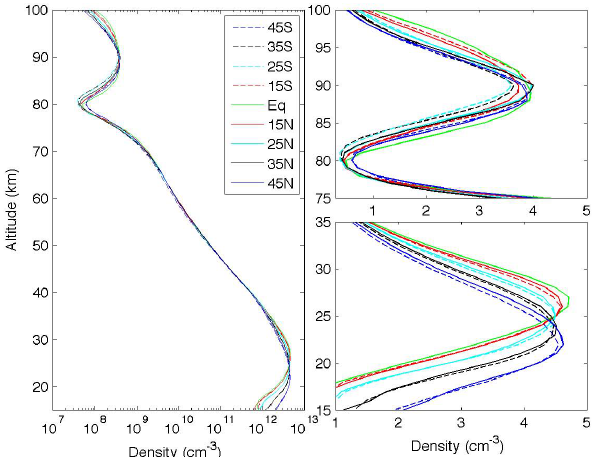
Fig. 11. The O 3 constant factor c(z) as a function of altitude for several latitude belts. The panel in left shows constant profiles 15– 100km at different latitudes. The upper right panel shows the same profiles in the MLT (values scaled by 10 8 ) and the lower right panel in the stratosphere (values scaled by 10 12 ).